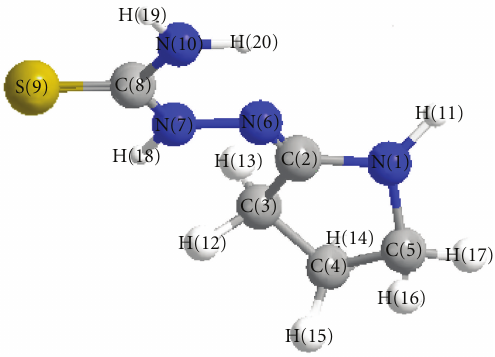
Figure 3: The 3d-geometrical structure for the ligand.